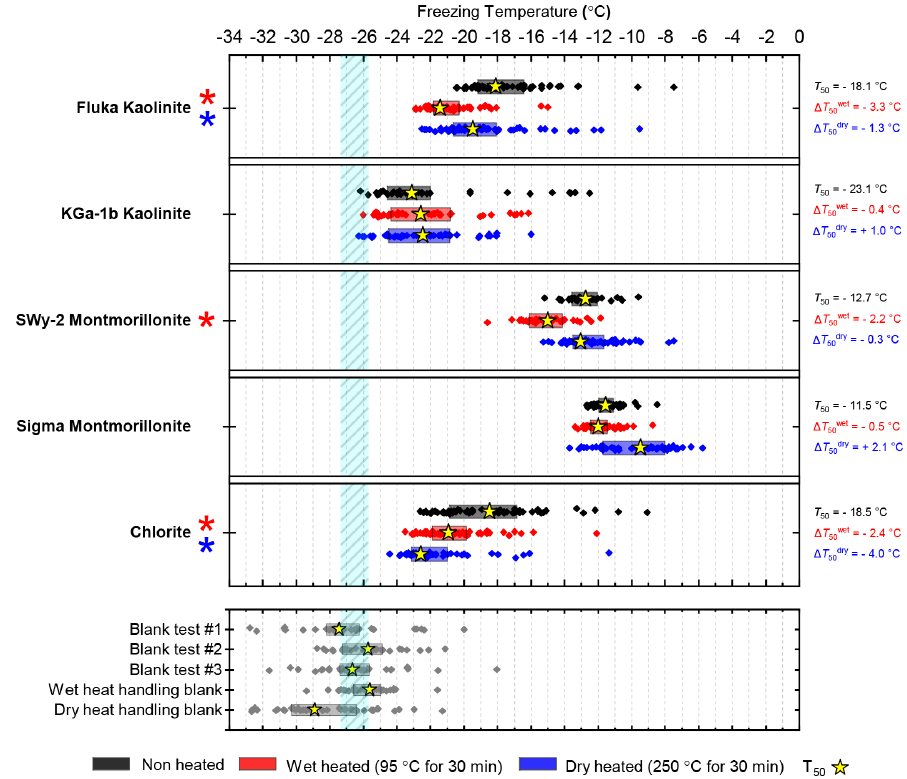
Figure 5. Boxplot showing freezing temperatures before (black) and after heat treatments (red for wet heat, blue for dry heat) for clay-based mineral